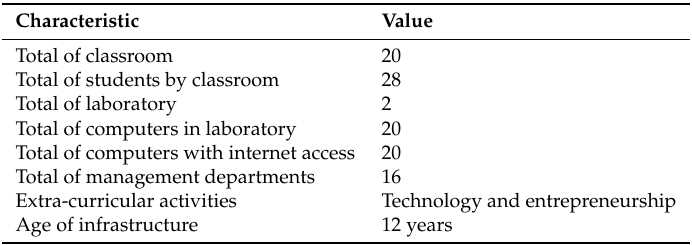
Table 6. Characteristics of the school.